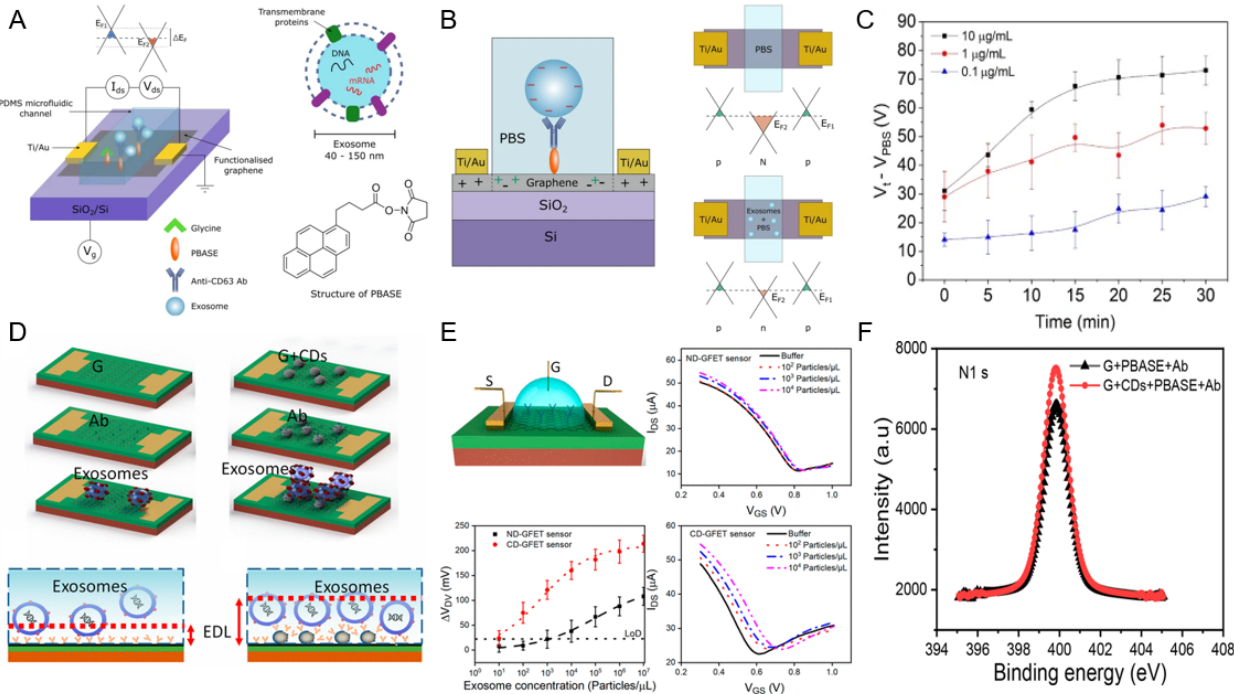
Figure 4. ( A ) Configuration of back-gate field effect transistor, ( B ) exosome detection principle of the proposed sensor, ( C ) sensor response according to exosome concentration in PBS buffer condition, ( D ) carbon dot applied graphene-based FET Schematic diagram of the sensor, ( E ) Comparison of exosome detection performance of sensors according to carbon dot application, and ( F ) sensor performance evaluation depending on whether carbon dot is applied. This was reproduced with permission from [35], published by Nature, 2019 and reprinted with permission from [37]. Copyright 2021 American Chemical Society.